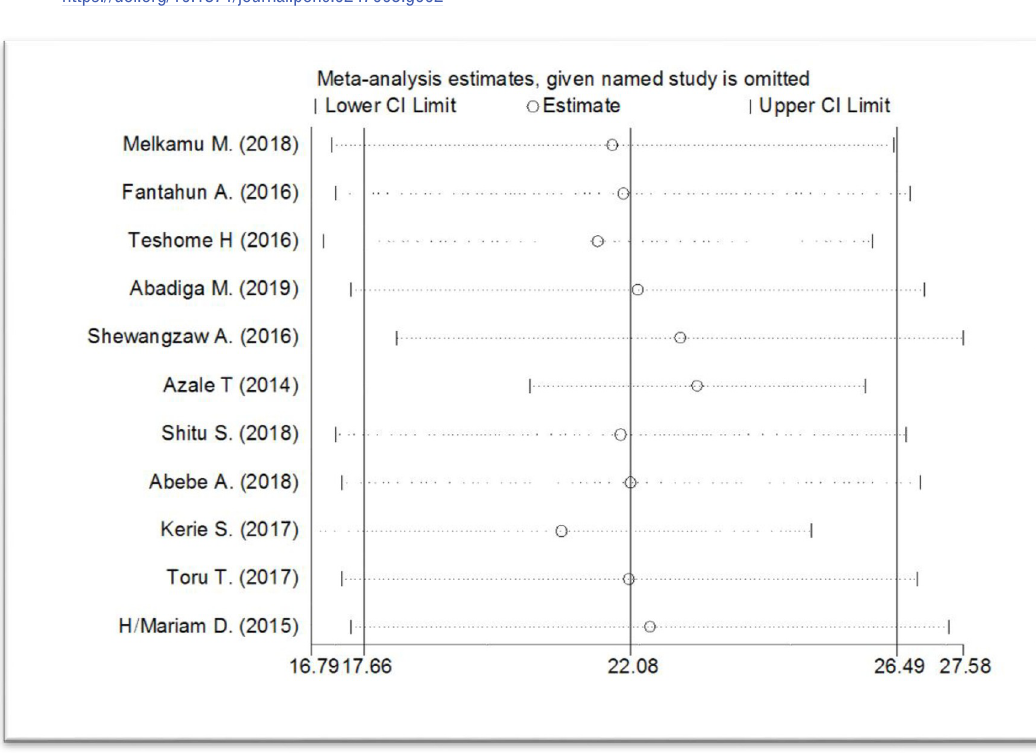
Fig 3. Forest plot presenting to show not having a single study influences the overall meta-analysis estimated of post-partum depression among after child giving mothers, Ethiopia, 2020. https://doi.org/10.1371/journal.pone.0247005.g003 PLOS ONE | https://doi.org/10.1371/journal.pone.0247005 February 19,